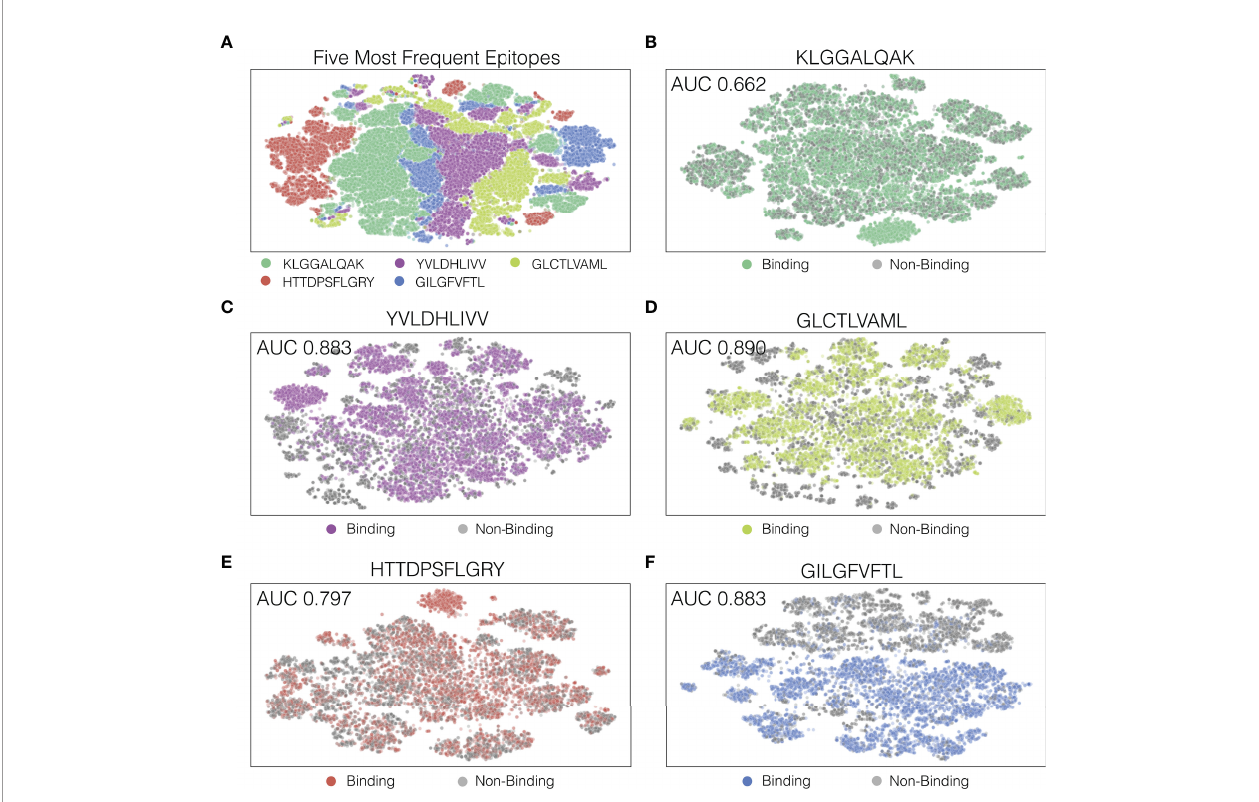
FIGURE 5 | Visualization of ATM-TCR ’ s last hidden layer using t-SNE plots. Each dot indicates a TCR-epitope pair (either binding or non-binding). Panel (A) displays the t-SNE plot of the fi ve most frequently appearing epitopes and the rest of the panels display t-SNE plots for (B) the most frequent epitope KLGGALQAK, (C) the second epitope YVLDHLIVV, (D) the third epitope GLCTLVAML, (E) the fourth epitope HTTDPSFLGRY, and (F) the fi fth epitope